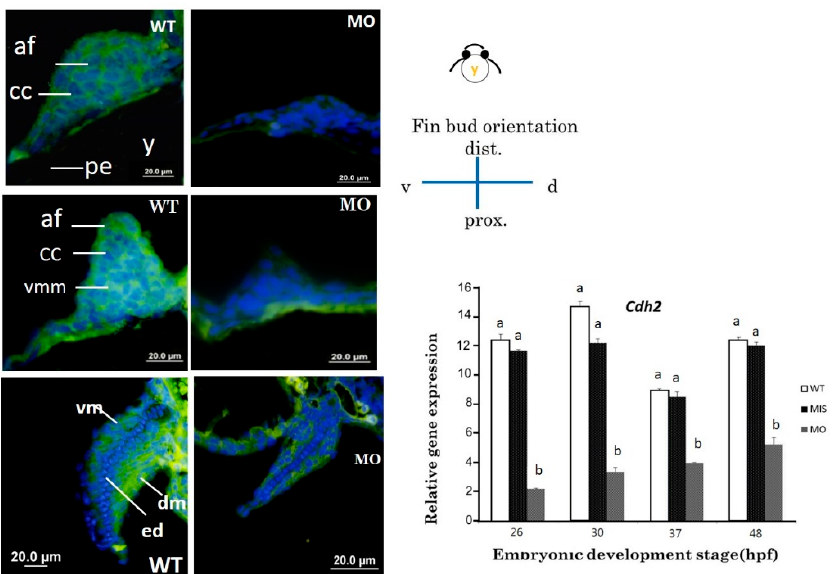
Figure 5. Cross sections of pectoral fins subjected to immunofluorescence staining for CDH2. Pectoral fins of wild-type embryos showed abundant N-cadherin surrounding chondrocytes at 37 ( A ) and 48 hpf ( C ). N-cadherin is observable in the dorsal and ventral muscular region surrounding the endoskeletal disc at 72 hpf ( E ). The tbx5a morphant with a stubby pectoral fin showed a lack of N- cadherin at 37 hpf ( B ), 48 hpf ( D ) and 72 hpf ( F ). cdh2 expression was significantly inhibited in the tbx5 morphant group at 26, 30, 37, and 48 hpf ( G ) ( n = 50 embryos, triplet). (cl, cleithrum; cc, chondrogenic condensation; dm, dorsal musculature; ed, endoskeleton disc; sco, scapulocoracoid; vm, ventral musculature; blue, nuclear; green, CDH2 protein, WT: Uninjected group, MIS: Control MO-injected group, MO: tbx5 morphant group, a, b: A significant difference was detected by one-way ANOVA with Duncan’s multiple range test. 3.6. Reduction in N-Cadherin Protein Expression in Pectoral Fins We used immunostaining to assess the localization of the N-cadherin protein (CDH2) in thin sections of pectoral fins. The formation of N-cadherin at 37 hpf was severely affected in the tbx5a morphant group compared with that in the control group, resulting in a severely hypoplastic pectoral fin (Figure 5). At the CC stage, the level of N-cadherin in the Uninjected group extended homogenously throughout the pectoral fin tissue at 37 hpf (Figure 5A), but only sparse N-cadherin was found in the tbx5a morphant group (Figure 5B). The levels of N-cadherin synchronized with the development of the dorsal and ventral myogenic mesenchymal mesoderm in the Uninjected group and extended homogenously throughout the pectoral fin tissue at 48 hpf (Figure 5C). In the tbx5a morphant group, the formation of N-cadherin was depressed and restricted in only the basement part of the pectoral fin at 48 hpf (Figure 5D). At the endoskeleton formation stage at 72 hpf, N- cadherin extended homogenously from the dorsal muscular structure to the trunk in the Uninjected group (Figure 5E). Both the ventral and dorsal muscular structures surrounding the endoskeleton myogenic mesenchyme exhibited high levels of N-cadherin in the Uninjected group (Figure 5F). The centrally located cartilage lacked N-cadherin and was well-formed at 72 hpf in the Uninjected group. Nevertheless, the perichondrial cells surrounding the forming cartilage in the Uninjected group exhibited high levels of N-cadherin (Figure 5E). The weak expression of N-cadherin could be detected in the stunted fins in the tbx5a morphant group at 72 hpf (Figure 5F).